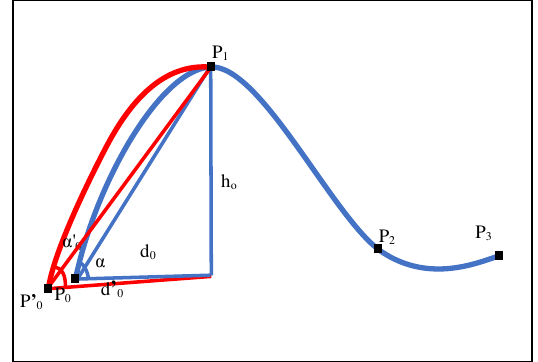
Fig. 2. The Different Chord Angles for the Same Chord